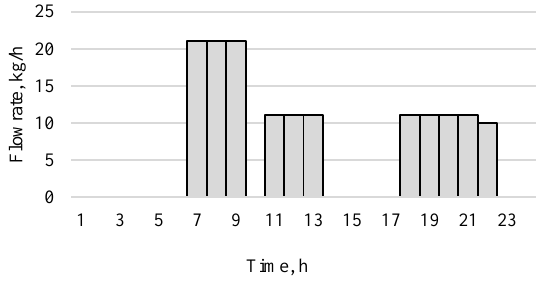
Fig. 1. Daily water draw-off